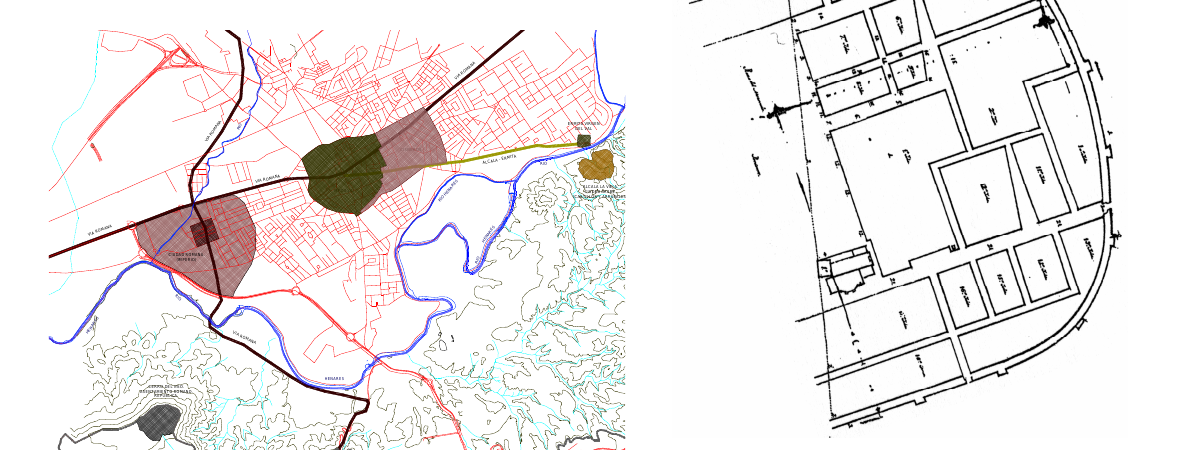
The University is now part of the city. The University extend outside the walls and it appropriates the remaining streets between buildings.